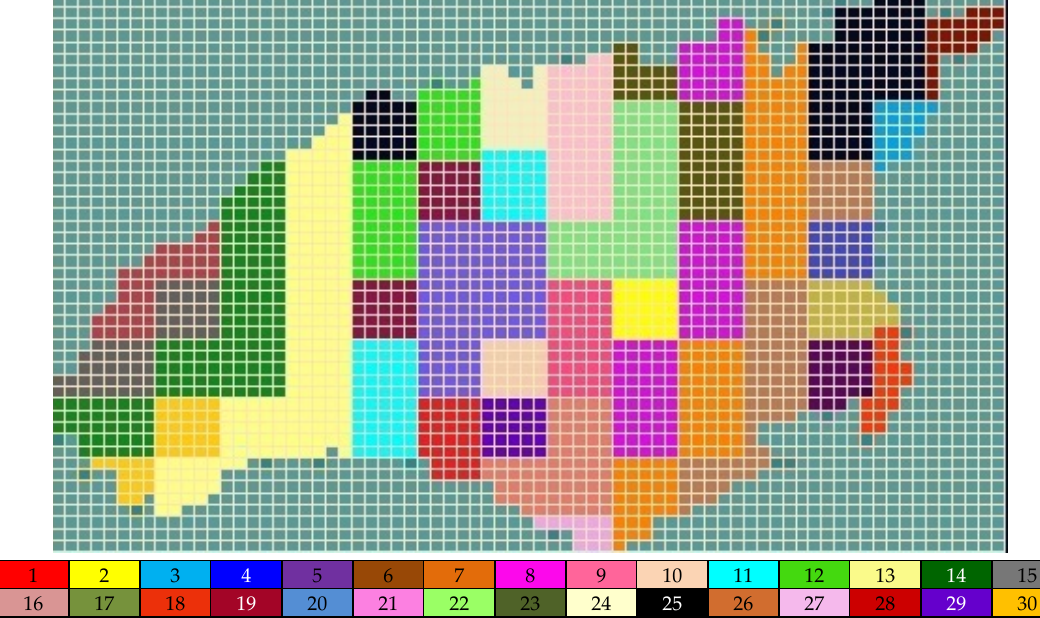
Figure 6. Spatial grid division and the HYDRUS module zones.